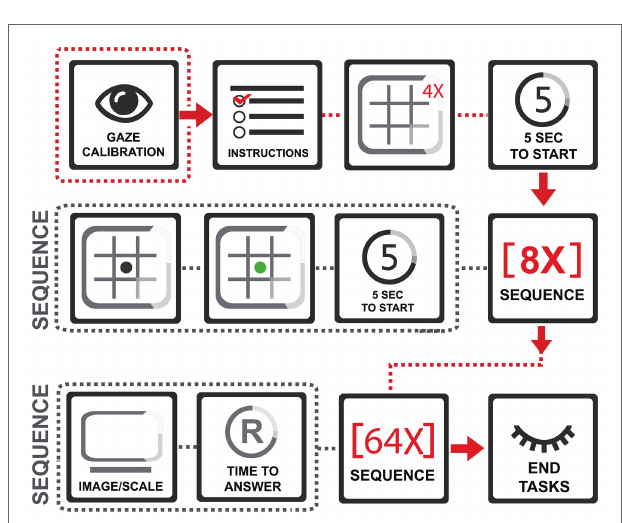
FIGURE 2 | Complete scheme of the task in the